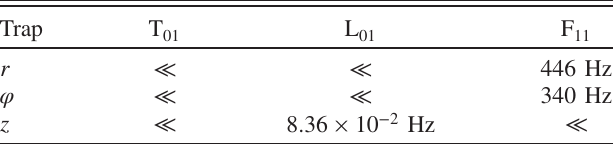
TABLE II. Atom heating rates. Listed are the contributions of the relevant phonon modes T 01 , L 01 , and F 11 to the heating rate Γ th of a trapped atom in direction i ∈ f r; φ ; z g calculated i according to Eqs. (11) and (12). Contributions below 10 − 4 HZ are indicated by “ ≪ . ” The rates are independent of the position of the trap site along the fiber. The fiber temperature is assumed to be T ¼ 805 K, and the remaining parameters are specified